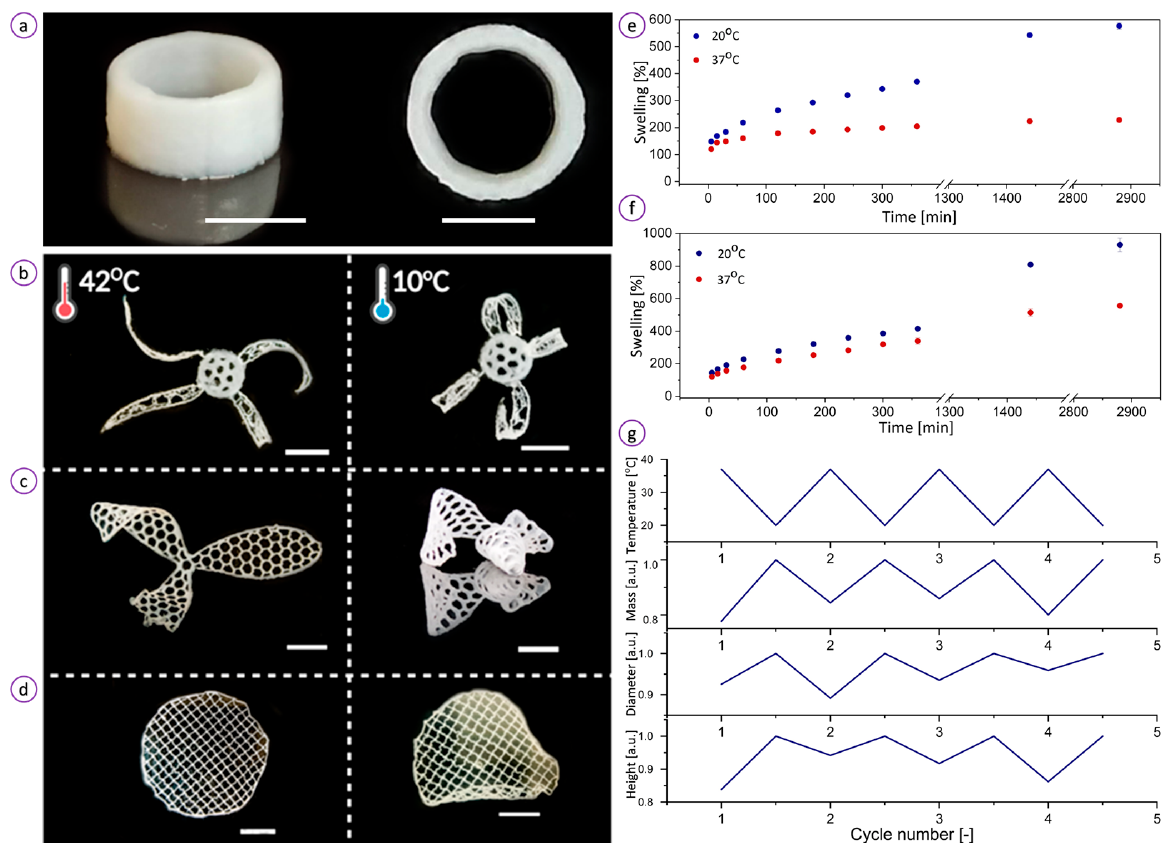
Figure 4. Three-dimensional (3D) printability and temperature-induced behavior of the hydrogel: ( a ) 3D-printed thermoresponsive tube demonstrates high printability of the ink. The combination of 3D printing and ink allows for the fabrication of hollow tubular structures, whose diameter alters in response to temperature change; ( b ) 3D-printed flower-like object with thermoresponsive petals and non-active core; ( c ) 3D-printed thermoresponsive hydrogel propeller; (4) 3D-printed thermoresponsive hydrogel disc. Figure ( b – d ) demonstrate that objects printed from the ink can be programmed to exhibit different actuation behaviors at different temperatures (42 and 10 ◦ C). Bars correspond to 1 cm. The hydrogel swelling rates at temperatures 20 and 37 ◦ C in water ( e ) and PBS ( f ); ( g ) Temperature-activated swelling (20 ◦ C) and de-swelling (37 ◦ C) cycles of the sample measured as a change of specimen height, diameter, and mass. The values are normalized to those at a temperature of 37 ◦ C.